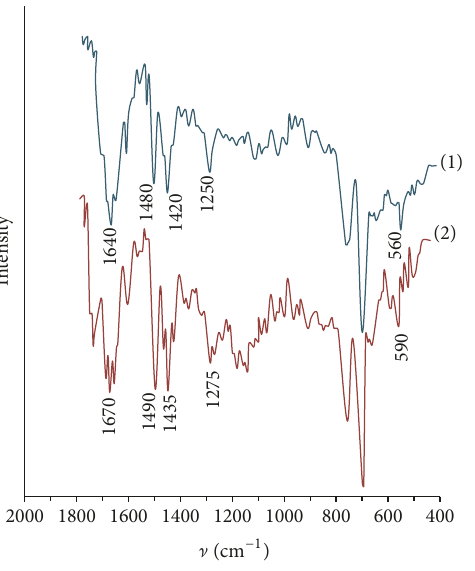
Figure 5: IR spectra of copolymer PVP-gr-PS (1) and MMA, a copolymer composition on based on it (2) .